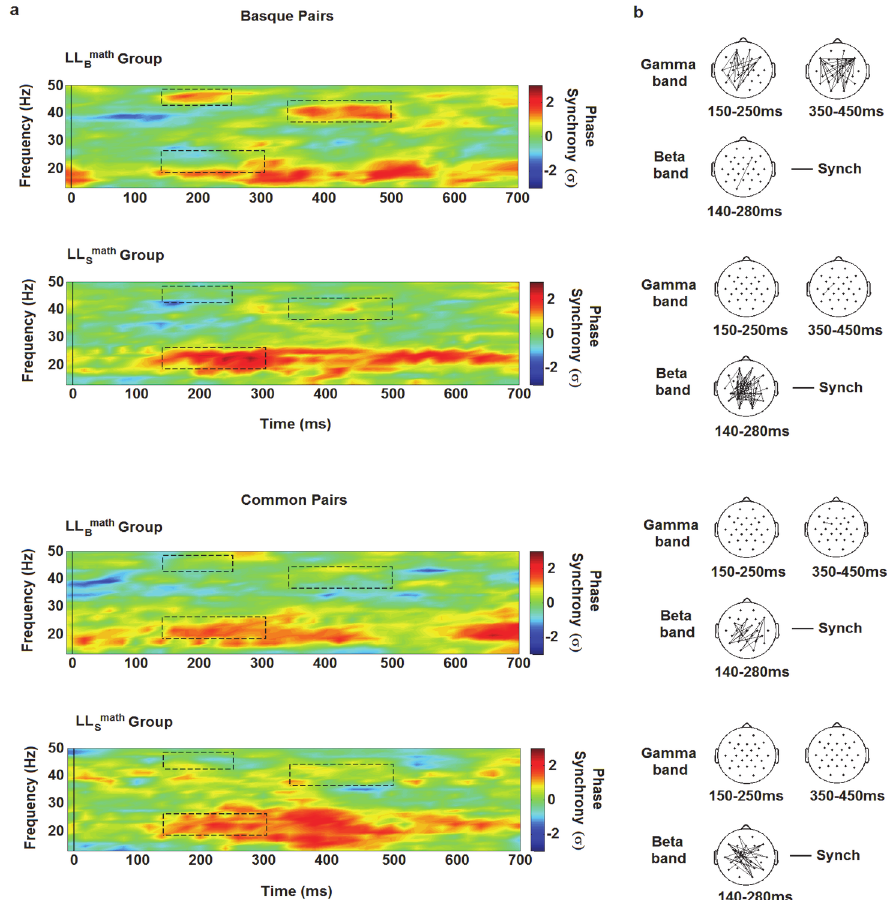
Fig 2. Phase Synchrony and its distribution over the scalp for each group and experimental condition. a) Frequency range and time are respectively indicated in the y and x-axis of the maps. Color bars at the right side of the maps show the mean phase-locking value (in standard deviation units) between all electrodes pairs. Vertical lines indicate the TN second digit onset. The black segment rectangles delimit time windows showing significant differences between conditions for the LL Bmath and LL Smath groups ( p < 0.05). b) Spatial distribution of phase synchrony for each significant time-frequency windows. The points represent the location of the electrodes over the scalp. Frequency bands are indicated at the left of each row. Time windows are indicated at the bottom of each head. Black lines connect pairs of electrodes displaying significant synchronization ( p <